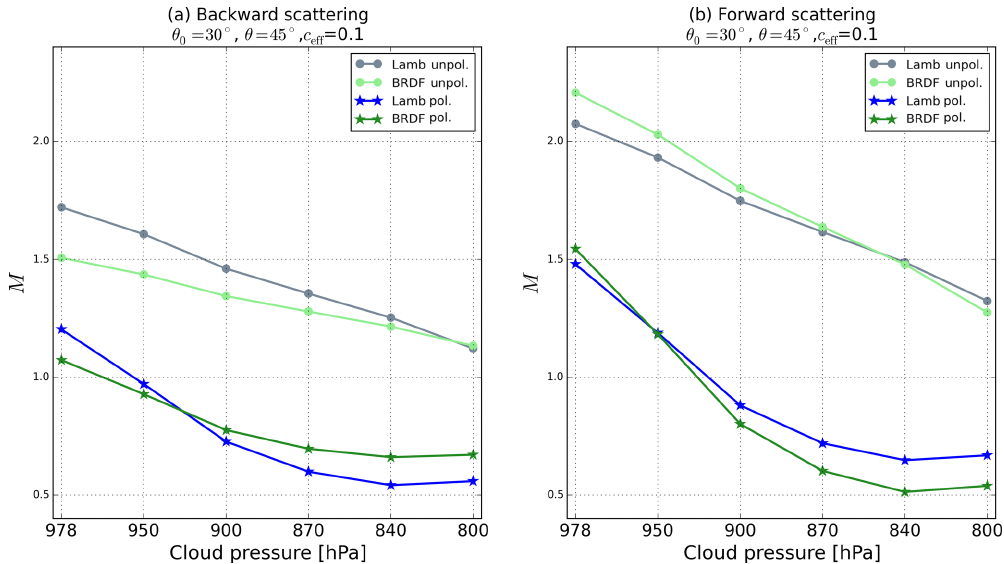
Figure 11. Total tropospheric NO 2 AMF as a function of cloud fraction in the (a) backward-scattering direction and (b) forward-scattering direction computed with surface BRDF (green) and a Lambertian surface (blue), for P cd = 850hPa, ( θ , θ 0 ) = ( 45 ◦ , 30 ◦ ), for a moderately polluted (stars) and unpolluted (circles) troposphere. BRDF parameters are ( f iso , f vol , f geo ) = ( 0 . 04 , 0 . 03 , 0 . 008 ) and A ws = 0 . 036 for the Lambertian